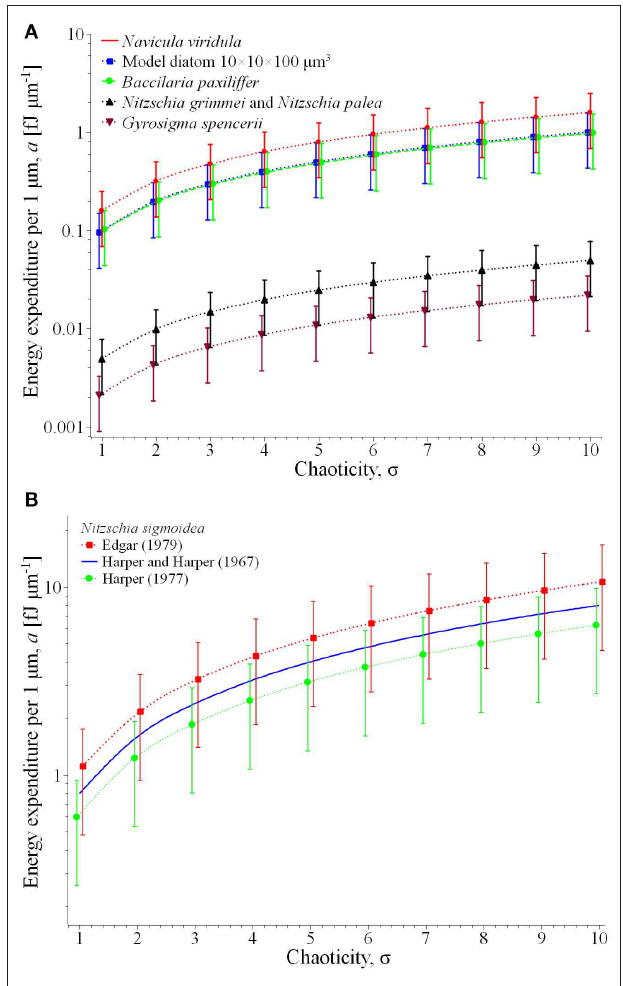
FIGURE 2 | Energy expenditure per 1 µ m of the displacement in the desired direction for the most representative species of Table 1 (A) and comparison of the specific results for Nitzschia sigmoidea (B)